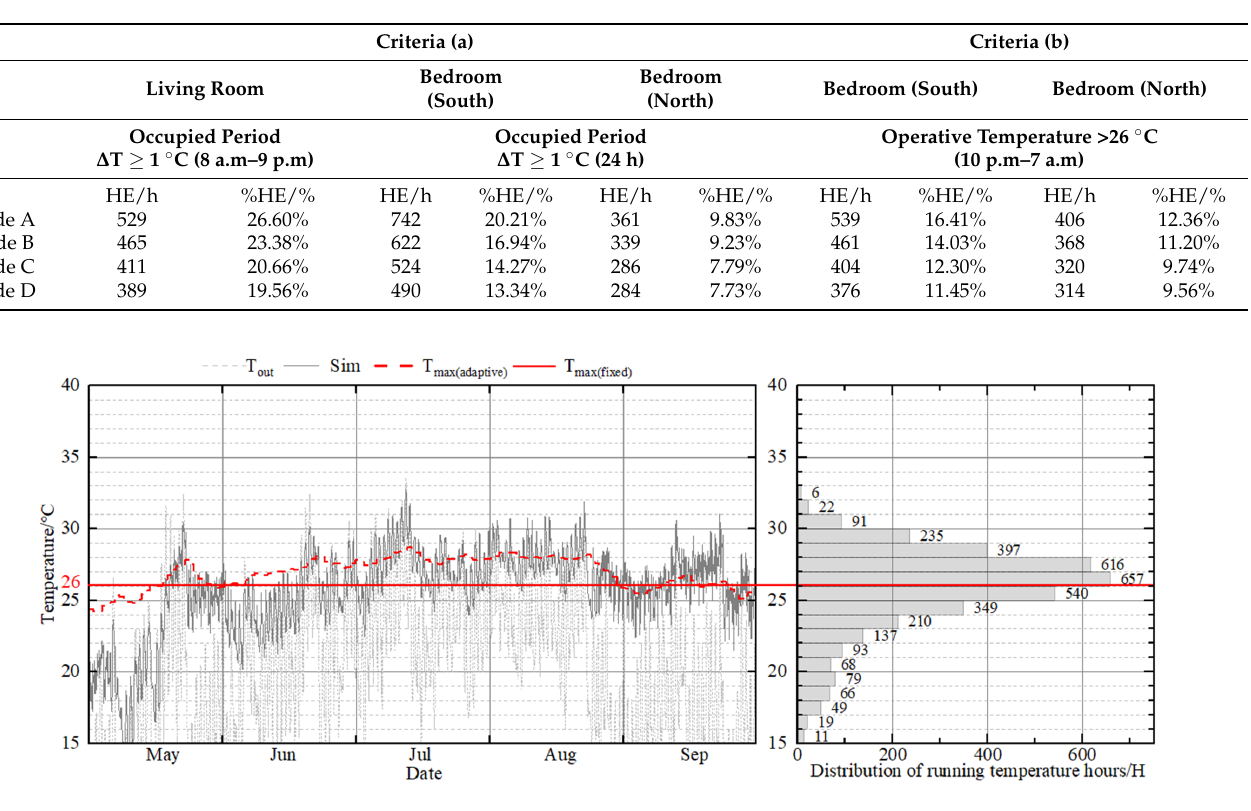
Figure 9. Indoor temperature of south-facing bedroom in temperature degree bands from May